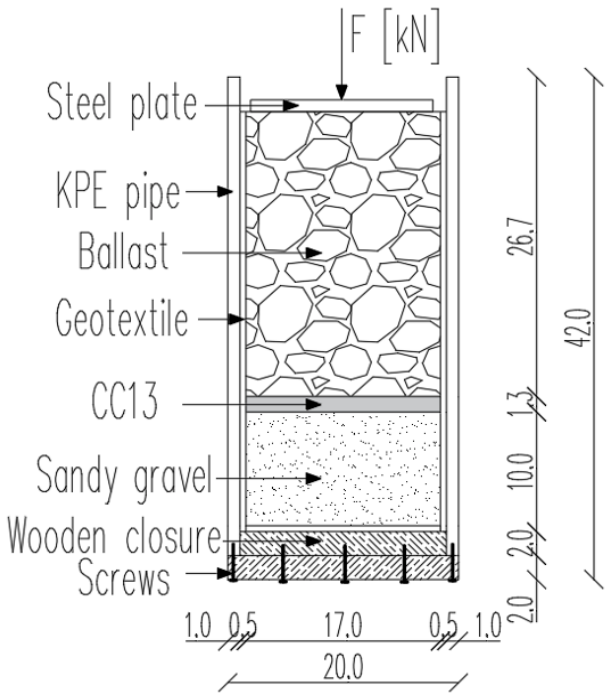
Figure 4. Set-up of the test specimens (KPE equals HDPE) (all the dimensions are in cm unit).